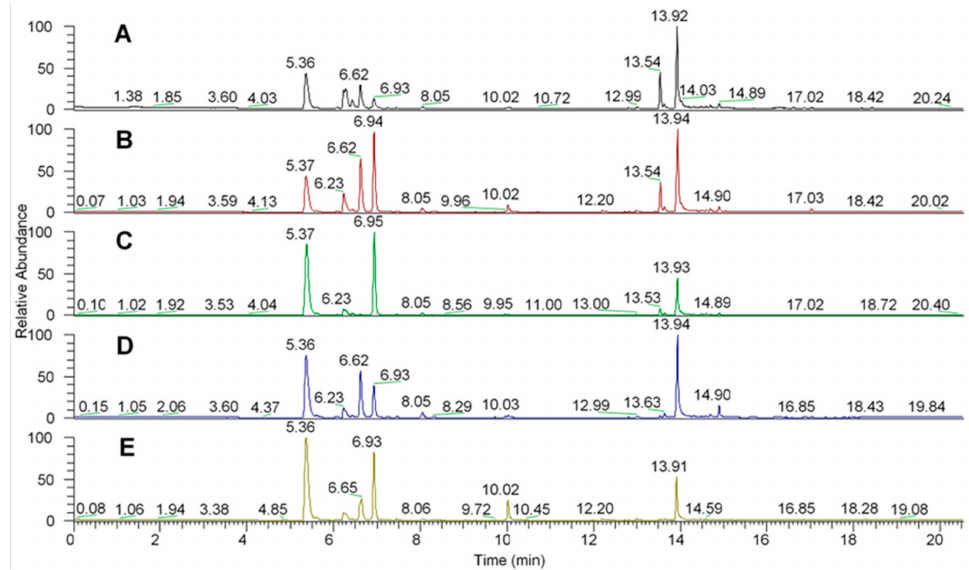
Figure 2. Chromatograms showing DVB/PDMS fiber VOC extraction results. Each chromatogram listed from ( A – E ) represents, respectively, matrices 1 to